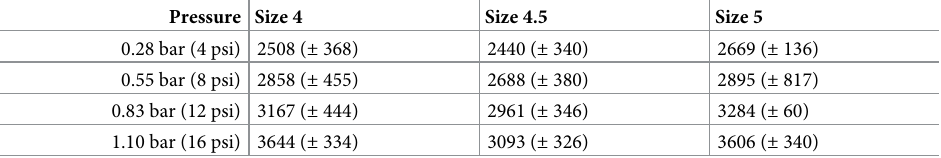
Table 3. Mean peak impact force (N) (+/- Standard Deviation) of all experimental trials within a 14-17 m/s velocity range.